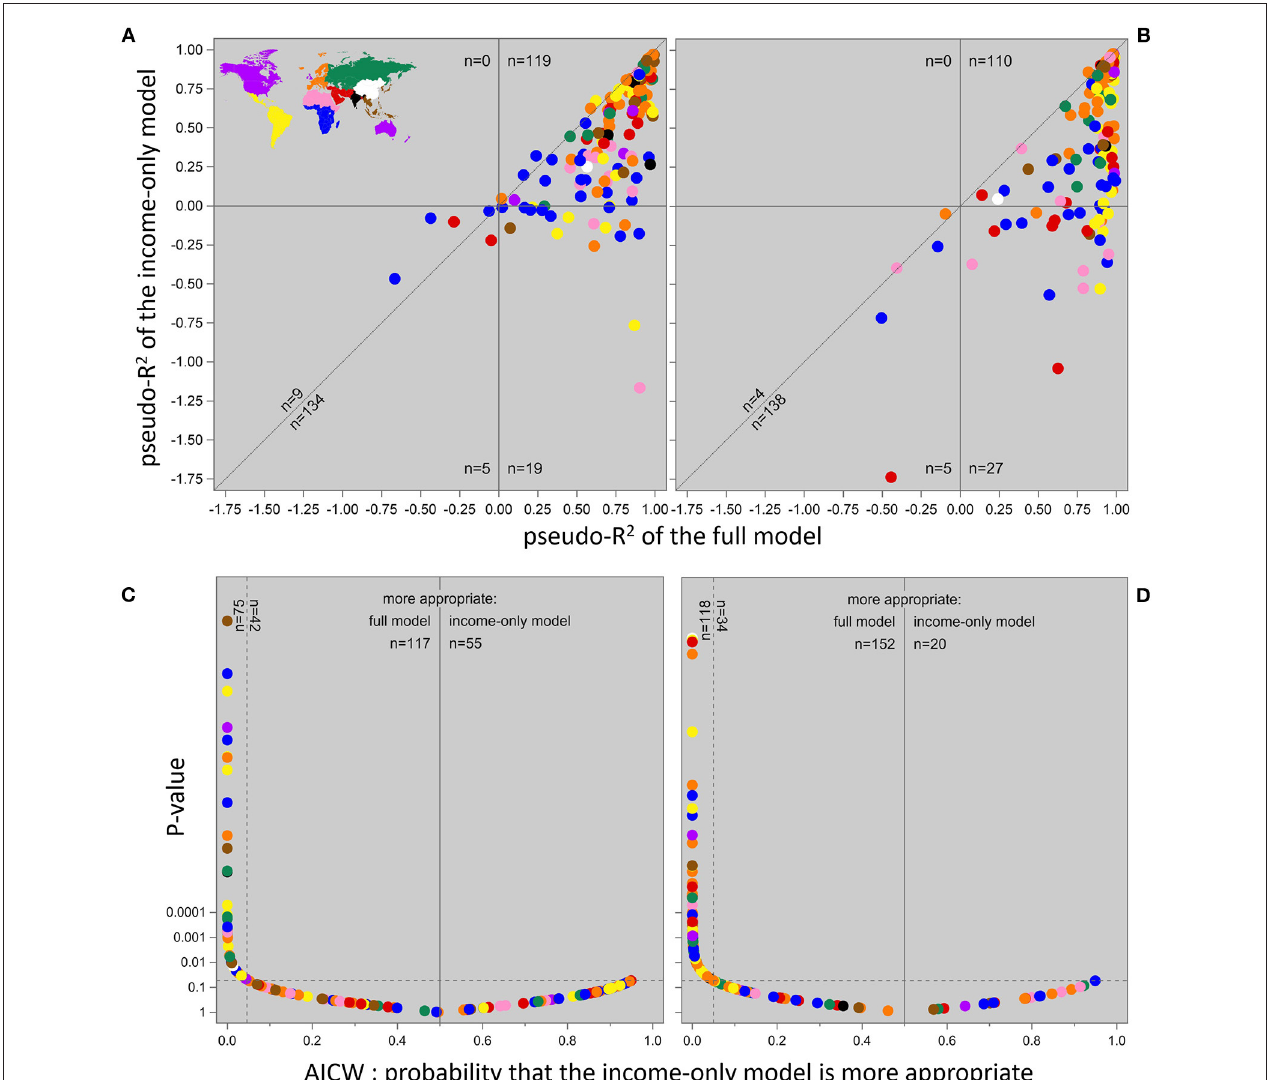
FIGURE 4 | Penalized pseudo-R 2 values of our full model (3) and its income-only submodel, for the contributions of animal source foods (A) and poultry meat (B) to protein consumption. Akaike Weights and the likelihood ratio test P -values of their underlying 1 AIC [i.e., P ( χ 2 2 > 1 AIC )] of our full model (3) vs. its income-only submodel, for the contributions of fish and seafood (C) and poultry meat (D) to protein consumption. Note that the y-axes in (C,D) are logarithmic and reversed, i.e., datapoints further to the top represent more strongly significant differences between the models. The horizontal reference lines in (C,D) indicate the most strongly significant cases where the income-only model is more appropriate; the dotted vertical reference lines indicate the AICW values where the full model achieves that same significance. Each datapoint represents a